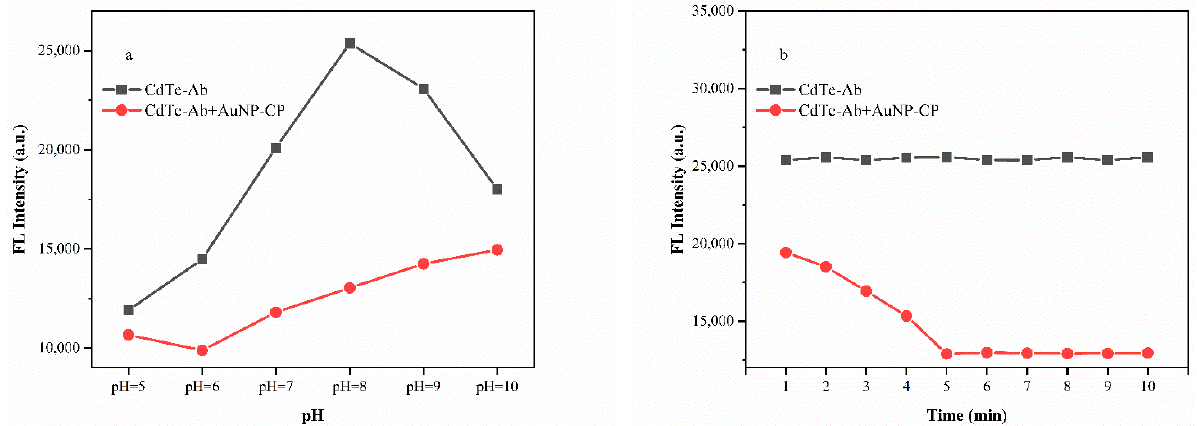
Figure 7. ( a ) buffer pH and ( b ) incubation time optimization for the best FRET efficiency.